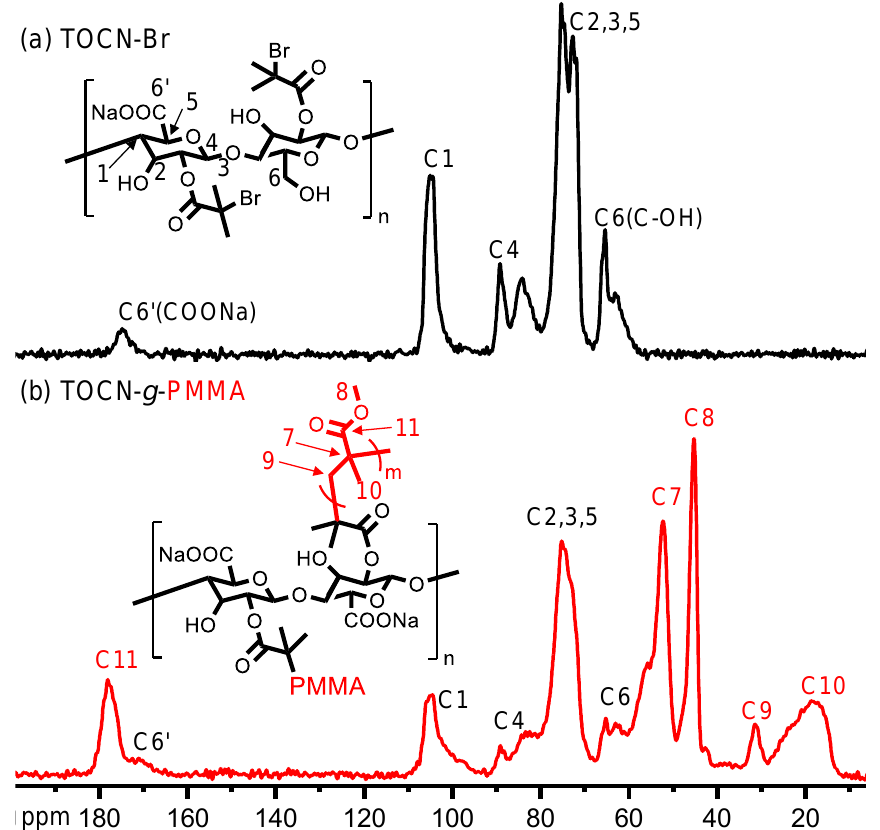
Figure 5. 13 C NMR spectra (100 MHz, DMSO– d 6 ) of ( a ) TOCN–Br and ( b ) TEMPO-oxidized cellulose nanofibers (TOCN)– g – PMMA.